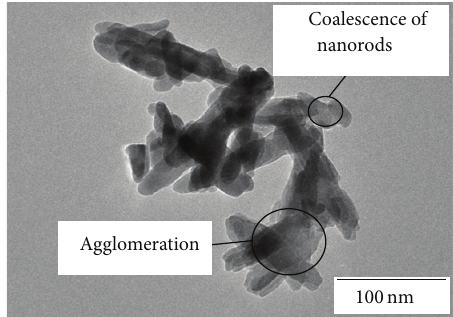
Figure 3: XRD pattern of HA powder.